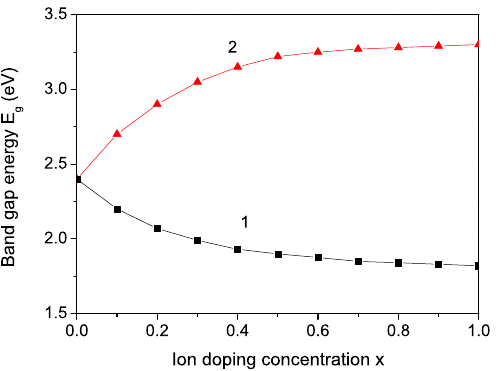
Figure 6. (Color online) Dependence of the band gap energy E g on the ion doping concentration x in CCO NP, N = 10, J s 1,2,3 = 1.2 J b 1,2,3 for (1) Co - J d 1 = 1.2 J b 1 ; (2) Pr - J d 3 = 0.8 J b 3 . All other interaction constants in the doped states are assumed to be nearly the same as in the undoped